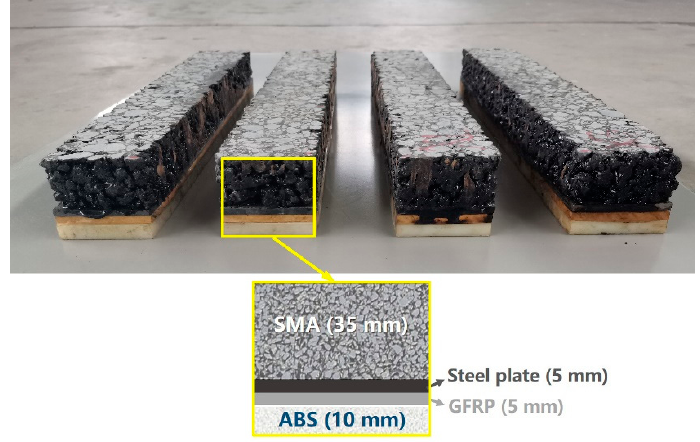
Figure 13. The specimen of ASP beam for fatigue testing.